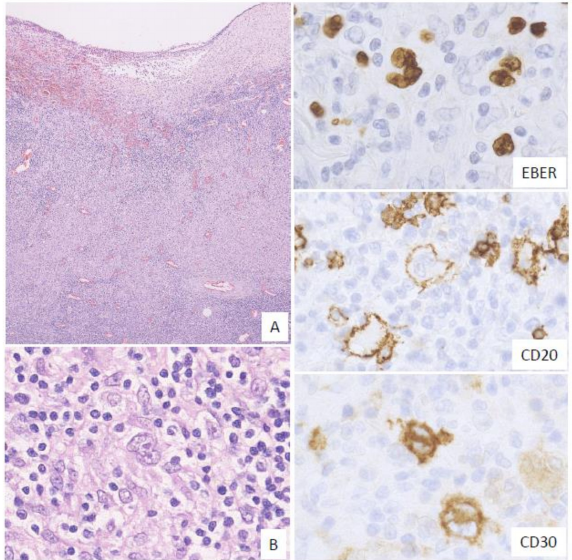
Figure 4. Pathologic findings for classic Hodgkin lymphoma (CHL)-like EBVMCU. A tonsillar EBVMCU in a patient undergoing methotrexate treatment. ( A ) Lymphoid cell infiltration with epithelioid granuloma is observed under the ulcer (magnification, × 40). ( B ) This lesion contains many Hodgkin and Reed–Sternberg (HRS)-like cells (magnification, × 400). The HRS-like cells and other polymorphous atypical lymphoid cells were positive for EBER; the HRS-like cells were also positive for CD20 and CD30 (EBER, CD20, and CD30: magnification, × 400).